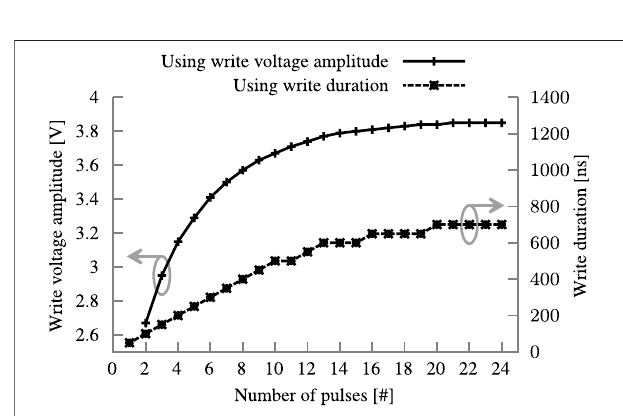
FIGURE 3 | Relation of the three different polarization schemes. Write amplitude has a fi xed duration of 1 µs, write duration a fi xed amplitude of 4 V. The fi xed pulse scheme uses 4 V with a 50 ns duration and 50 ns pause in- between pulses.